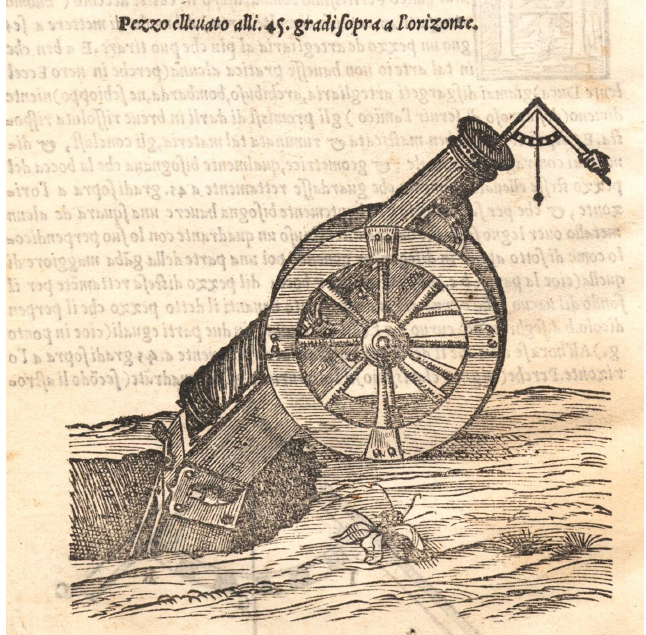
Fig. 3 Tartaglia N.,